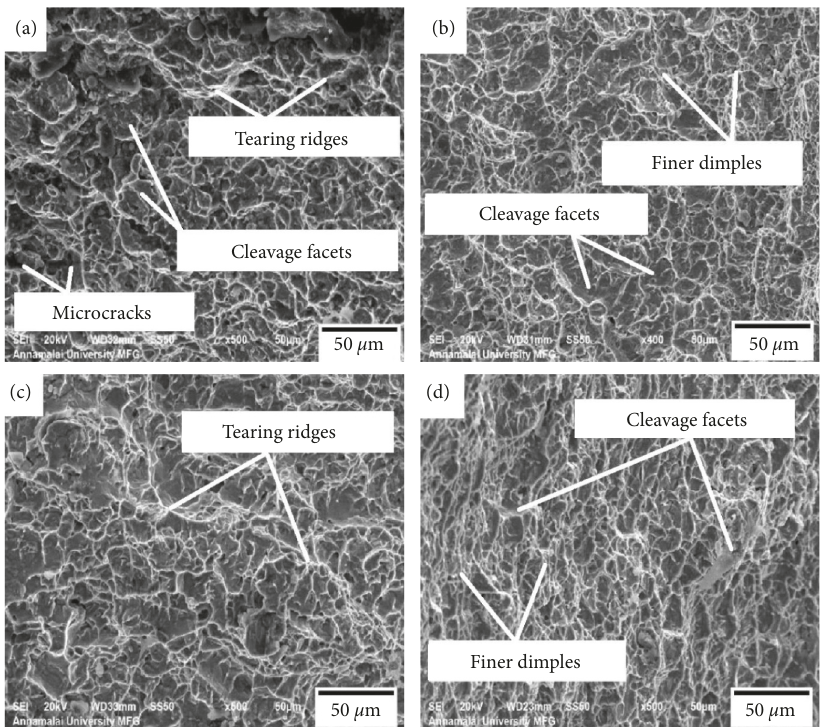
Figure 16: SEM fractographs of different regions of the impact toughness specimen of the LFW joint: (a) crack initiation zone; (b) crack propagation zone; (c) border of crack propagation and shear lip zone; (d) shear lip